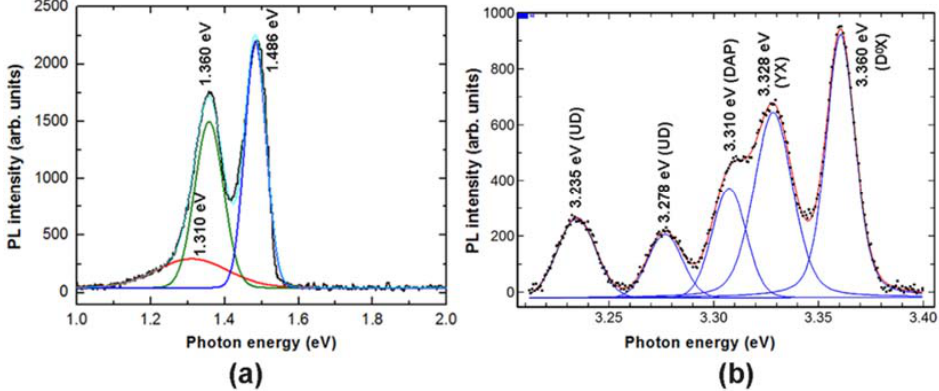
Figure 5. Unpolarized PL spectra of a GaAs nanowire array coated with a thin ZnO layer measured at 10 K in the IR spectral range ( a ), and in the UV range ( b ).